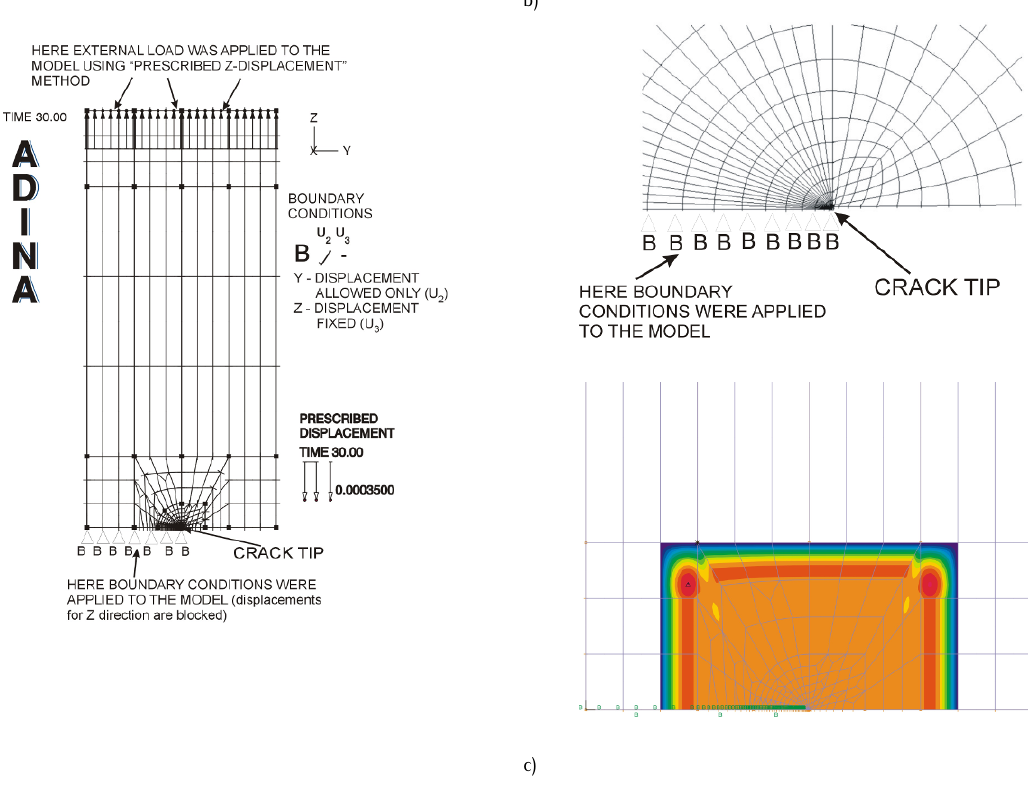
Figure 6. a) Finite element model for SEN(T) specimen used in numerical analysis; b) Crack tip model used to modeling the CC(T) specimen; c) One of the twelve integral contours for calculation of the J -integral using virtual shift